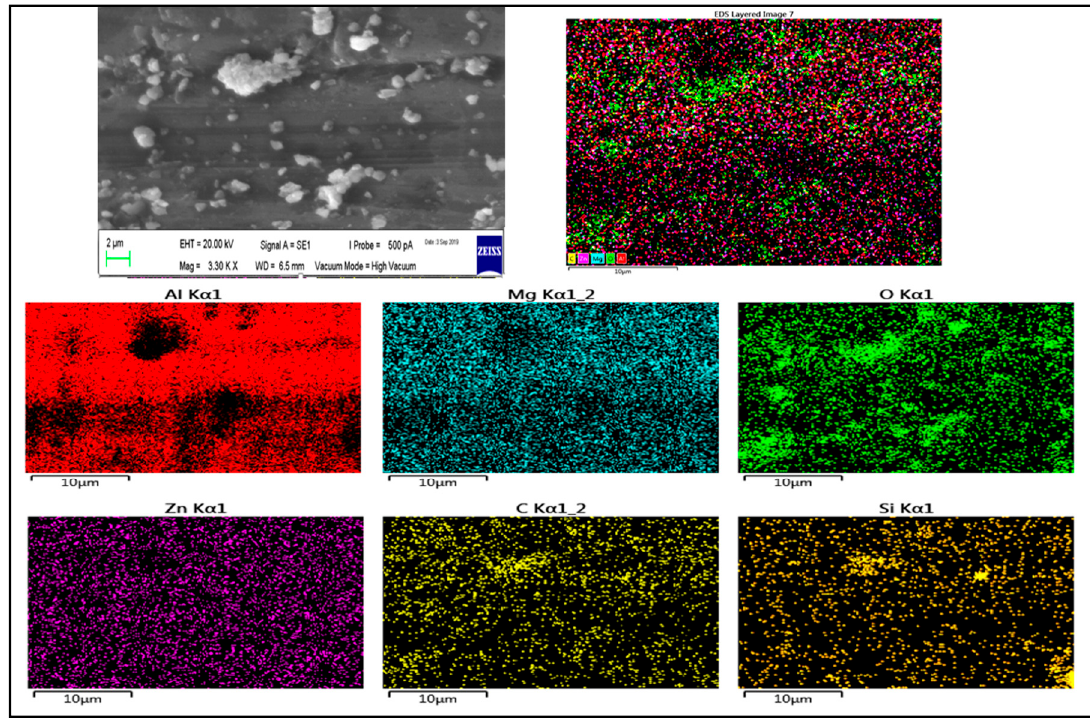
Figure 6 . SEM-Mapping analysis of Run 20-AA7075-SiC/fly ash composite. Figure 6. SEM-Mapping analysis of Run 20-AA7075-SiC / fly ash